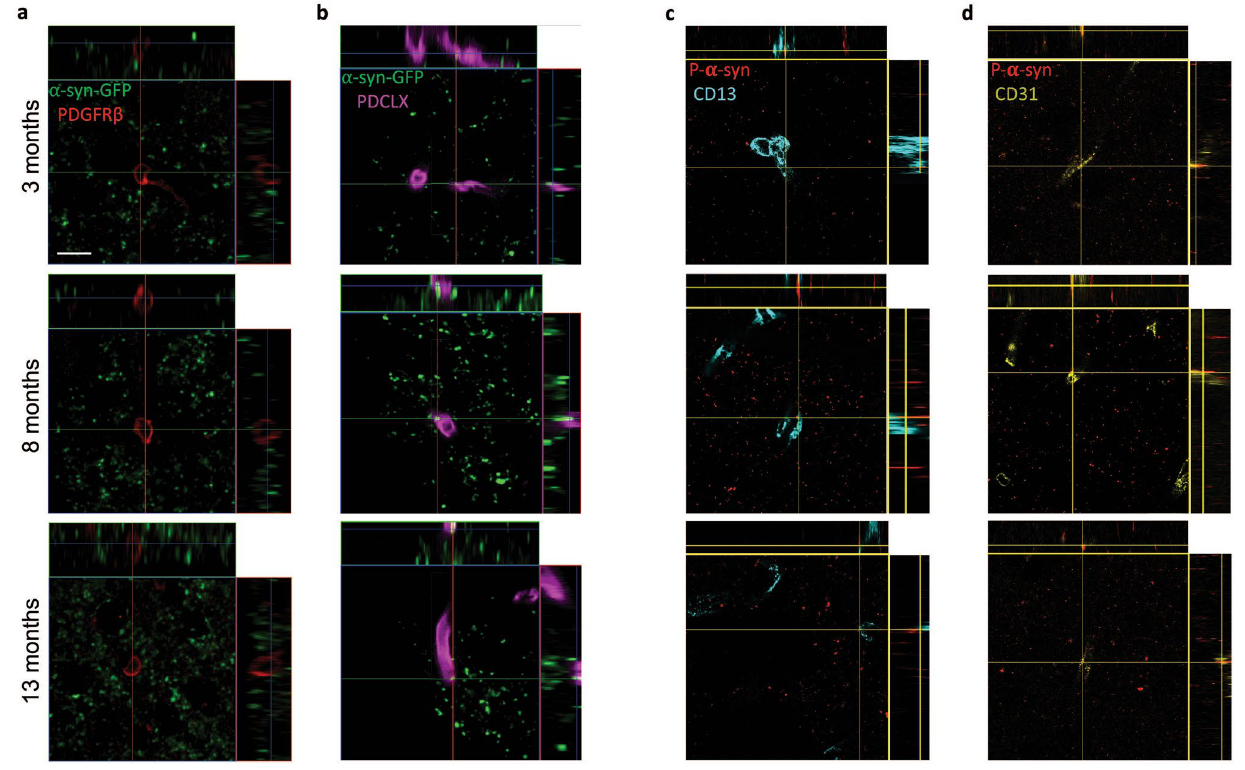
Figure 8. α-syn-GFP and pS129-α-syn inclusions are present in endothelial cells but not in pericytes. ( a ) Confocal pictures illustrating that α-syn-GFP does not co-localize with PDGFRβ + pericytes ( b ) but shows co-localization with PDCLX + blood vessels in the striatum of TG mice at age of 3, 8, and 13 months. ( c ) Confocal images showing pS129-α-syn does no colocalizate with CD13 + pericytes ( d ) but it colocalizes with CD31 + vessels in the striatum of TG mice at age of 3, 8 and 13 months. PDGFRβ = Platelet-derived growth factor receptor-beta, PDCLX = Podocalyxin, α-syn-GFP = alpha-synuclein green fluorescent protein, pS129-α- syn = phospho S129-alpha-synuclein. Scale bar: 10